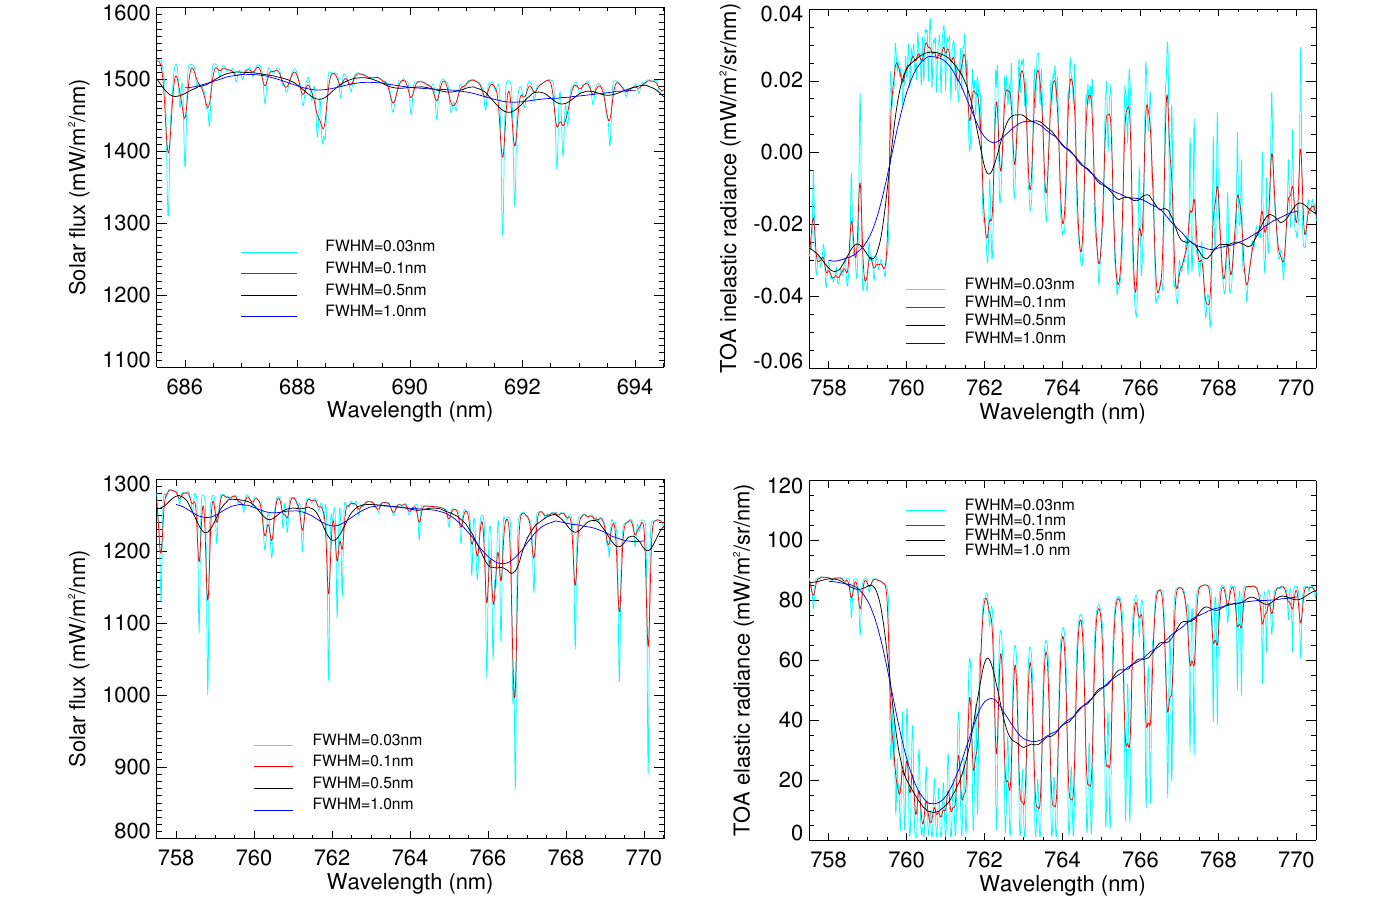
Fig. 3. TOA radiances, inelastic (top) and elastic (bottom) for SZA=45 ◦ , at nadir, and surface reflectivity 0.3.